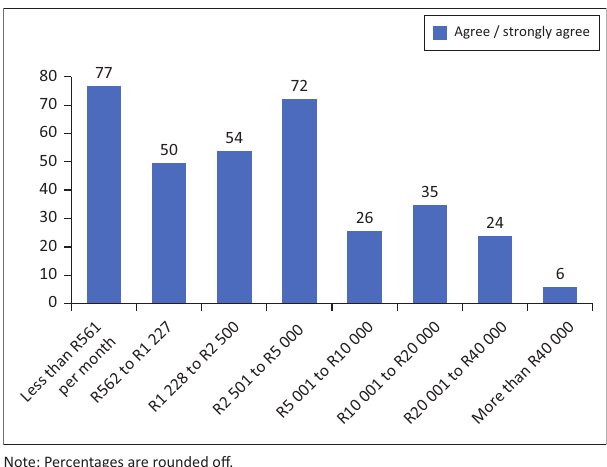
FIGURE 3: Government had taken the needs of persons with disabilities into account by income ( N =